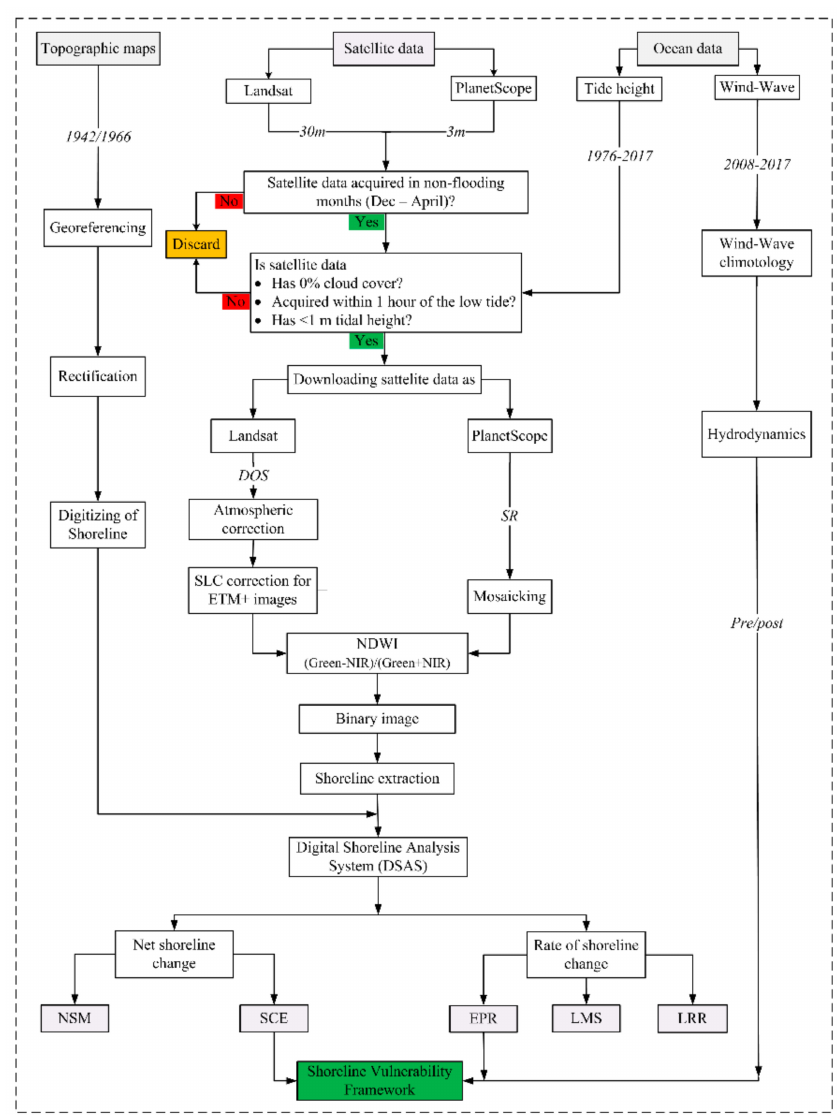
Figure 2. Flowchart of the methodology for the shoreline change detection along the coast of Karachi from 1942 to 2018. (SLC = Scan Line Corrector, SR = Surface Reflectance, NSM = Net Shoreline Movement, SCE = Shoreline Change Envelope, EPR = End Point Rate, LMS = Least Median of Square, and LRR = Linear Regression